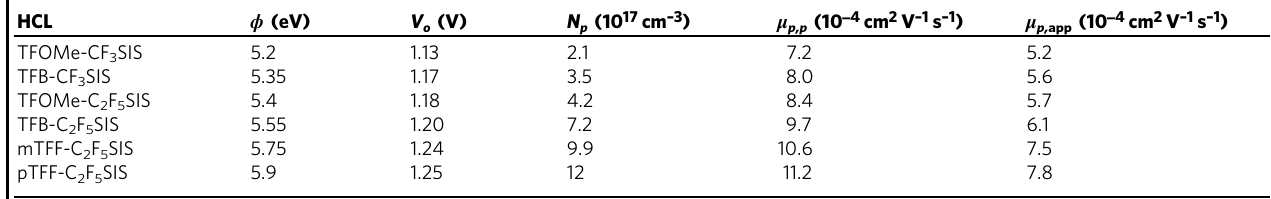
Table 1 Input parameters for drift – diffusion – generation